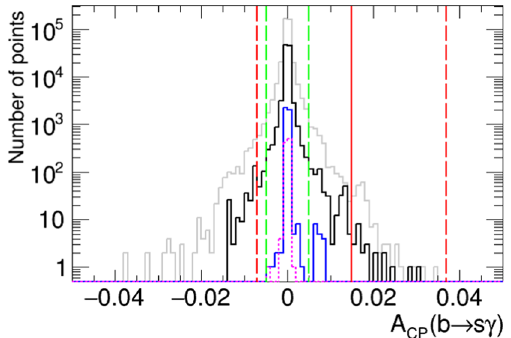
Fig. 8 Distribution of the CP asymmetry in b → s γ , A CP ( b → s γ) . The red dashed line shows the current experimental constraint, while the red solid line indicates its central value, and the green dashed line shows the prospective future sensitivity of Belle-II. Grey histogram: all points passing the LHC mass and flavour constraints; black: also including current EDM limits; blue: including a possible future proton EDM constraint, assuming a central value of zero; magenta: including a possible future proton EDM measurement of 1 × 10 − 27 e.cm, both with an assumed uncertainty of ± 0 . 025 × 10 − 27 e.cm